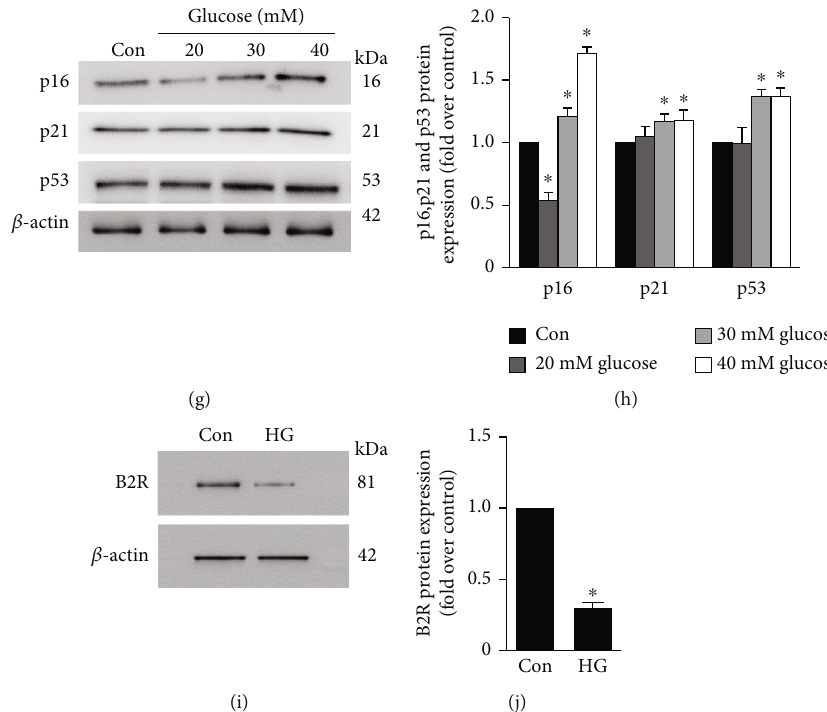
Figure 2: HG induced senescence in EPCs. (a) Representative photomicrographs of SA- β -gal staining in EPCs. (c) Number of senescent cells after treatment. (b, d) ROS generation was analysed by Mito-Sox. (e) Cell viability was evaluated by CCK-8 assay. (f) NO production was detected by NO assay kit. (g, h) Western blotting for p16, p21, and p53 in EPCs. (i, j) B2R protein levels 48 h after HG treatment. Bars represent the means ± SD ( ∗ P < 0 : 05 versus control; n = 6